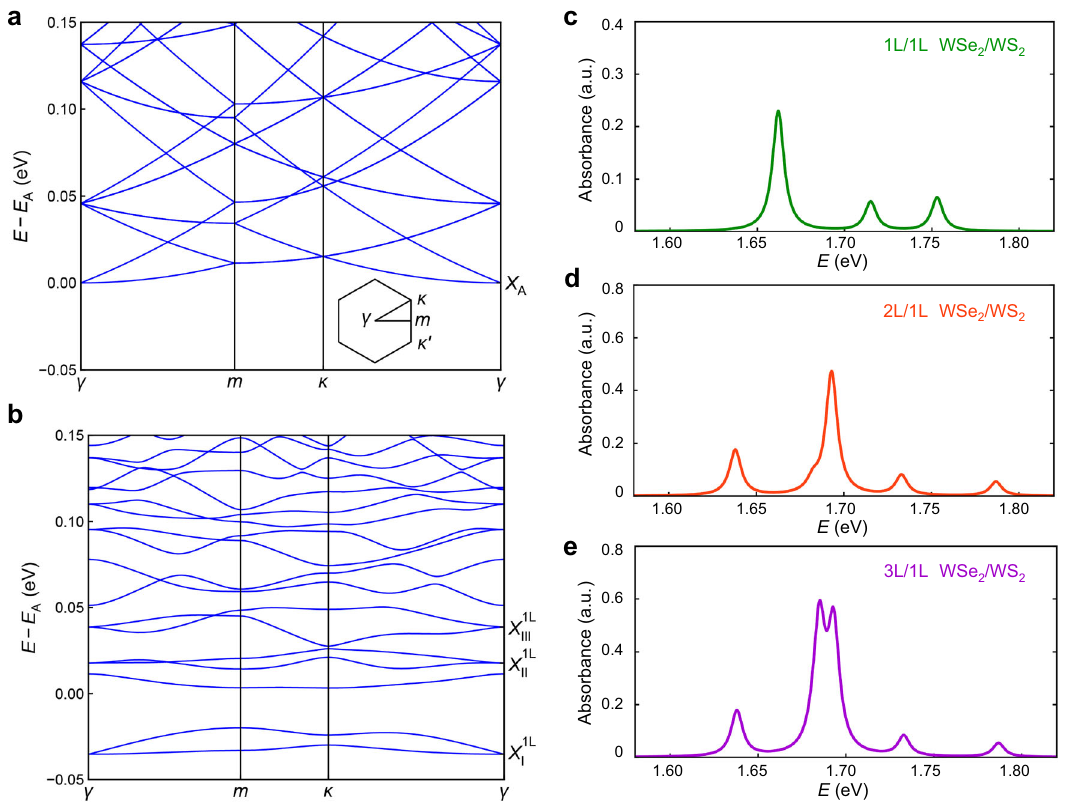
Fig. 2 | Theoretical simulation of moiré excitons. a , b are the energy bands of bare intralayer A excitons in 1L WSe 2 and moiré excitons in 1L/1L WSe 2 /WS 2 , respectively. a The A exciton bands are folded into the mini-Brillouin zone of the moiré superlattice to compare directly with that of moiré excitons in b . Inset of a shows the schematic of the mini-Brillouin zone and the label of high symmetry points. The WSe 2 bright intralayer A exciton state is marked by X A in a . The three